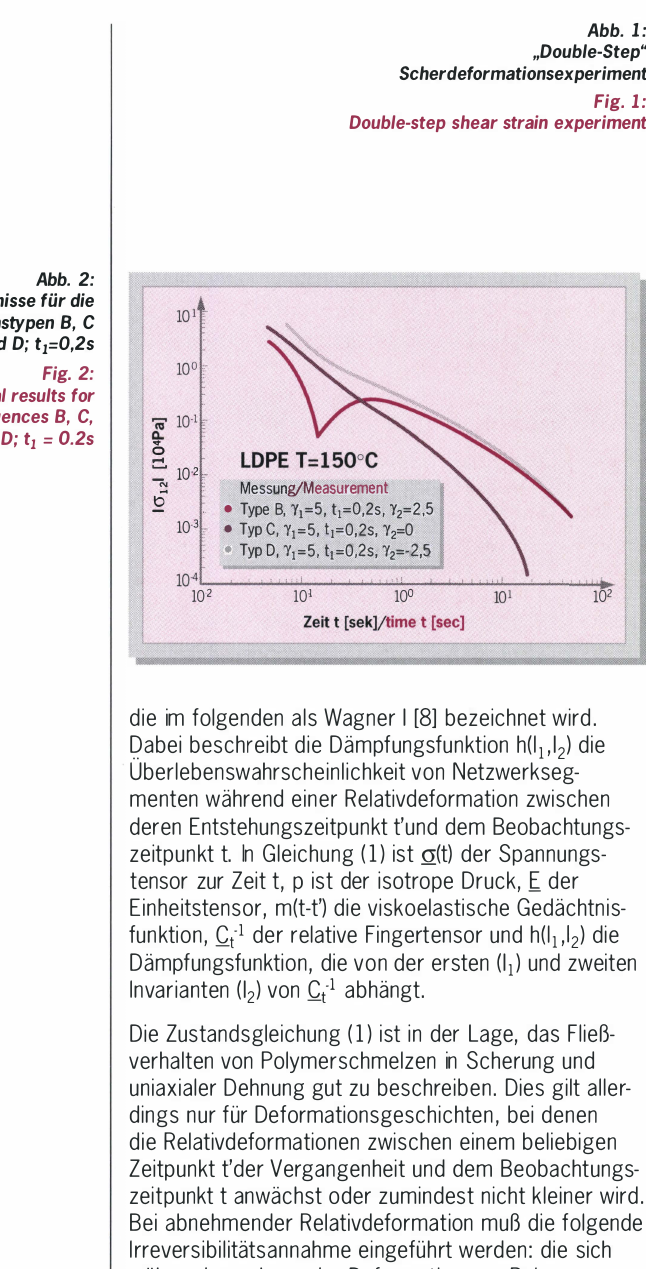
Double-step shear strain